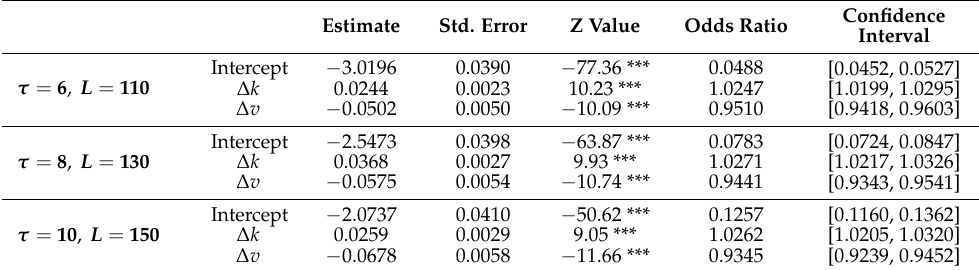
Table 3. Summary statistics for the logistic regression of different cell